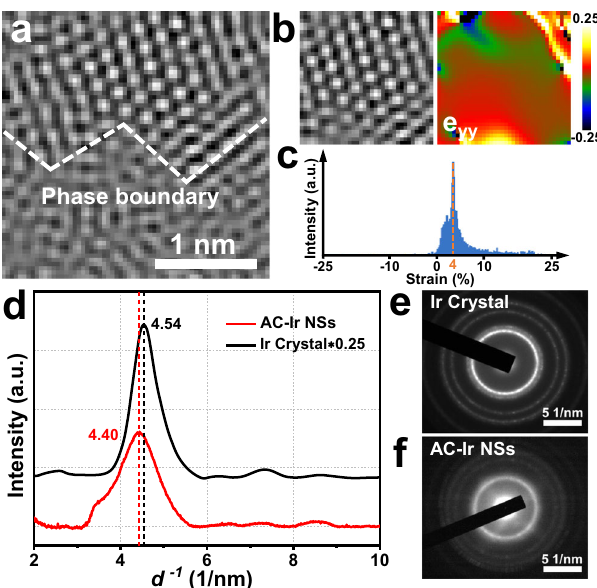
Fig. 3 Strain distribution across the amorphous – crystalline boundary in AC-Ir NSs. a HRTEM image of amorphous – crystalline boundary. b HRTEM image (left) and e yy strain component (right) of crystalline domain. c The histogram of strain distribution. d Electron diffraction pro fi le of AC-Ir NSs and Ir crystal. e , f Selected area electron diffraction pattern (SAED) of Ir crystal and AC-Ir NSs, respectively. Note: the lattice strain e yy is associated with the expansion/contraction of the lattice vector along the in-plane y